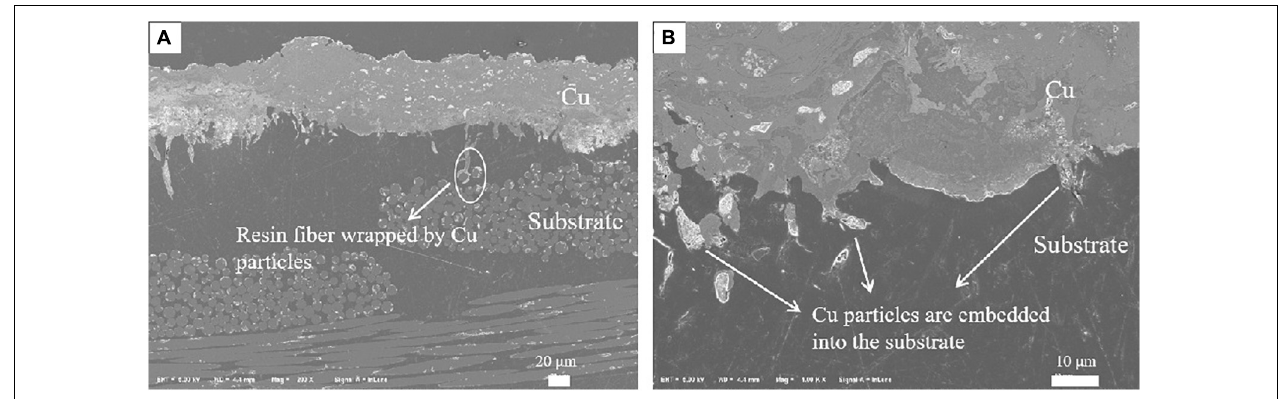
TABLE 4 | The velocity, kinetic energy and temperature of different particles in HVOF flame.